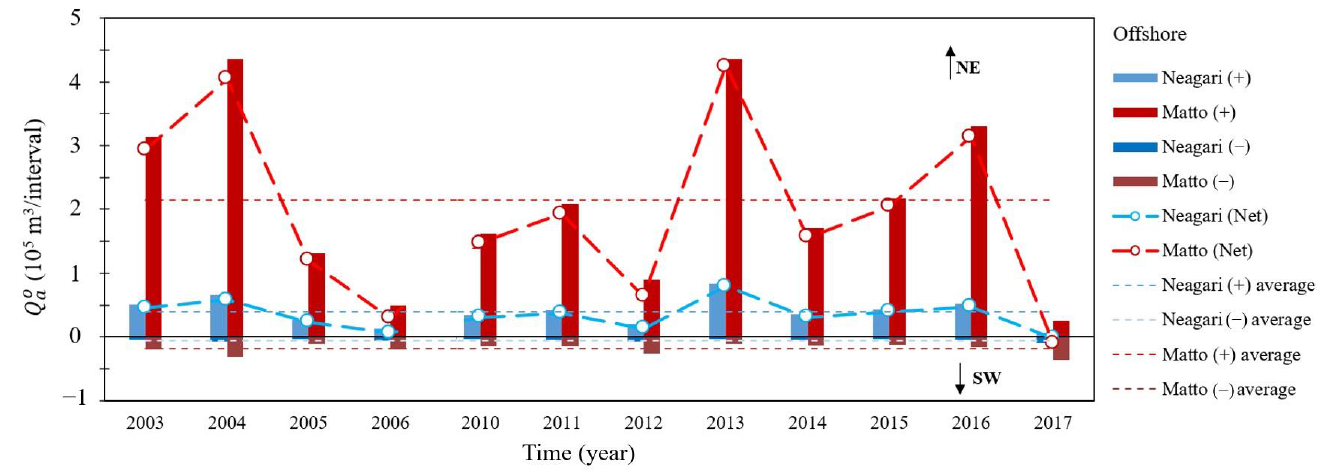
Figure 7. Cumulative and net sediment transport in the surf zone, both cumulative and net value in each interval (calculated approximately once a year based on the date of bathymetric surveys con- ducted annually). Since sediment moves in both directions, the positive and negative terms are dis- played in addition to the value’s sum.